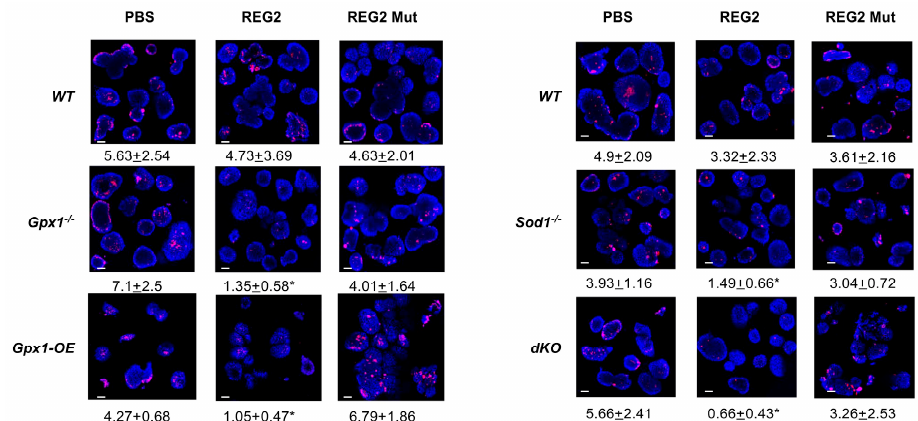
Figure 2. BrdU (red) immunostaining of pancreatic islets (blue) isolated from WT, Gpx1 -/- , Gpx1-OE, Sod1 -/- , and dKO mice. Islets were incubated with REG2 and REG2 Mut for 48 h before the proliferation assay. Numbers under the image panel represent relative BrdU fluorescent intensity, and means with * differ at p < 0.01 compared with the PBS control. Data were analyzed using Student’s t test within each genotype. Representative images are displayed for each condition; n = 4. Scale bar = 50 µm.